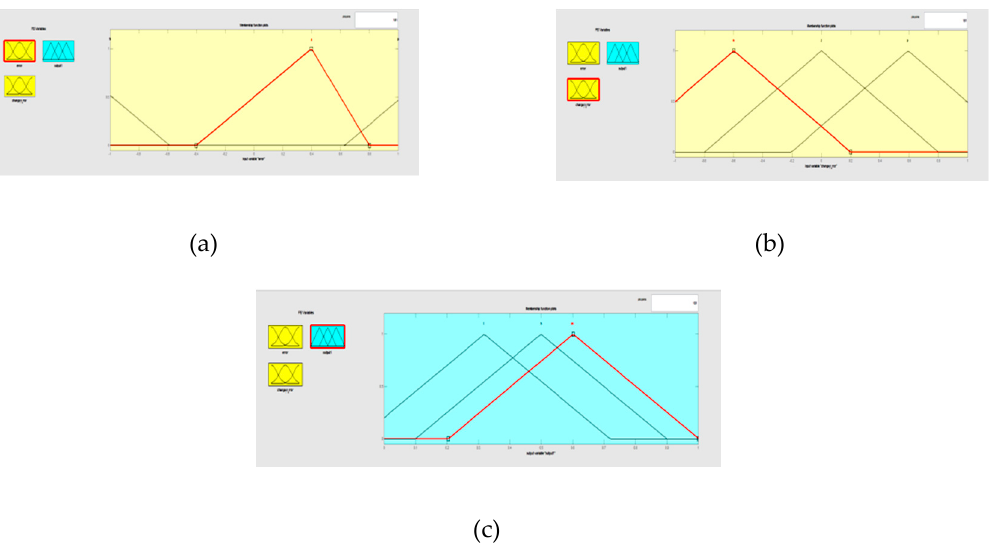
Figure 14. Membership Functions of fuzzy sets: ( a ) Input 1(error); ( b ) input 2 (change in error); ( c ) output.